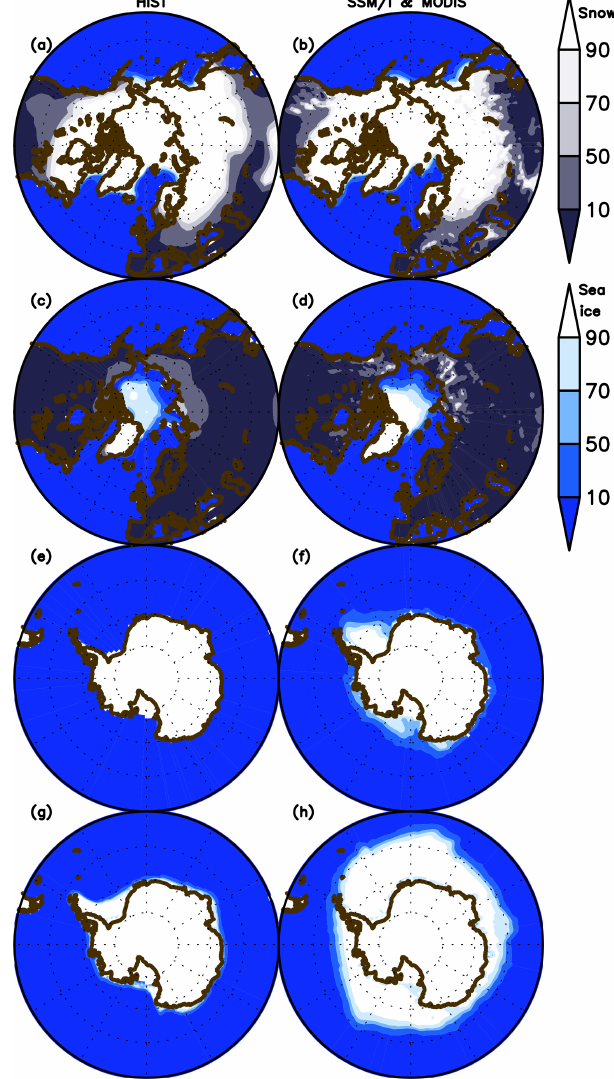
Figure 6. Northern Hemisphere sea ice concentration and land snow fraction (%) in the HIST simulation presented as a 2003– 2013 climatology and in comparison with SSM/I (Kaleschke et al., 2001) and MODIS (Hall et al., 2006) data for (a, b) March and (c, d)